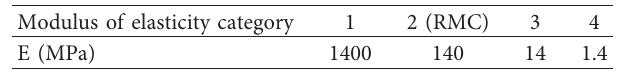
Table 6: Change in value of elastic modulus E of the wall panel. Modulus of elasticity category